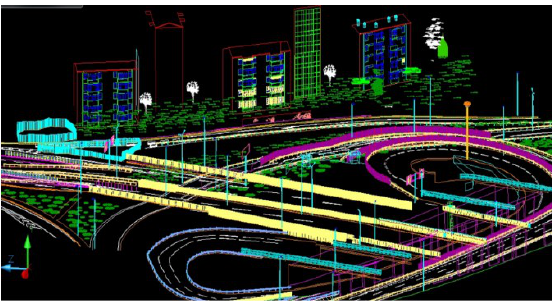
Figure 13: 3D CAD data derived from mobile scanning